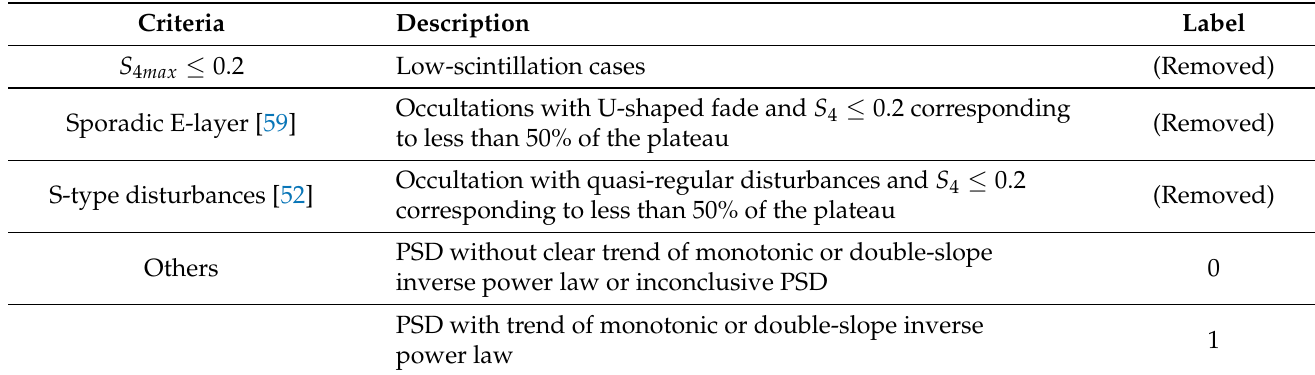
Table 1. Conditional checks and classes assumed during data set